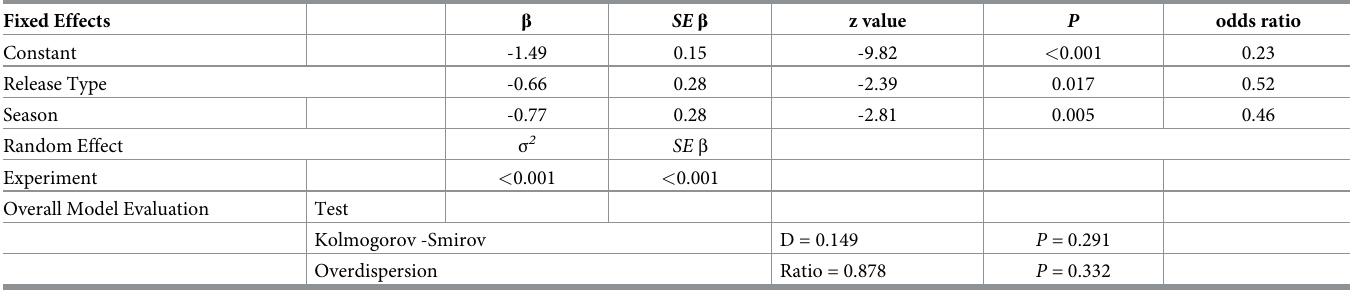
Table 3. Results of the mixed effects logistic regression model on daily proportion of females mated. Results show the effect of release type (single or multi-point) and season (early and late summer) on the daily proportion of rhodamine B inseminated females